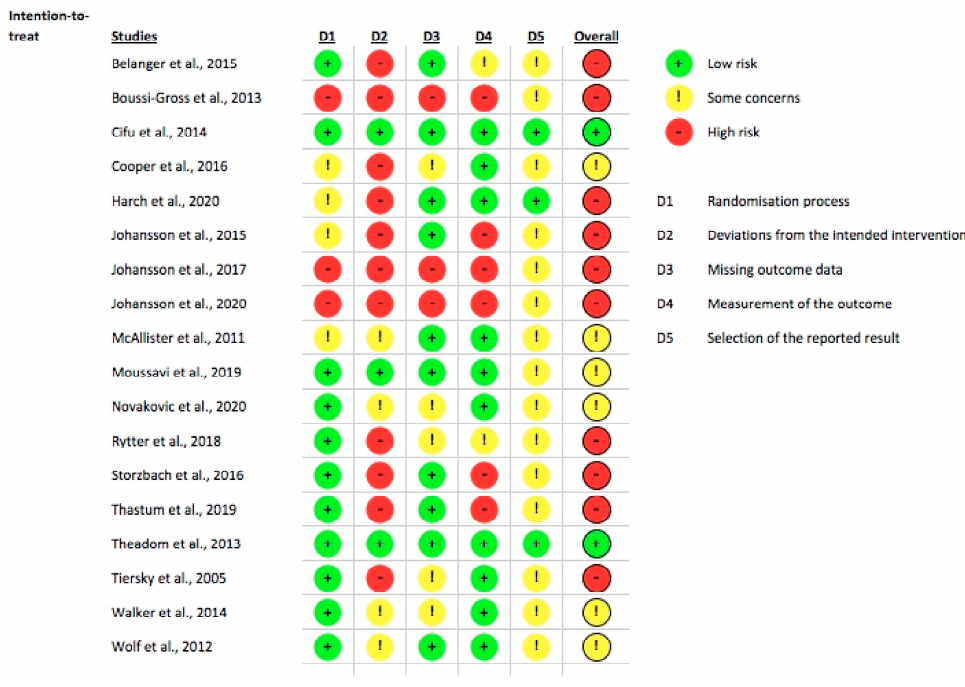
Figure A1. Risk of Bias for each study included in the Section 3.1, assessed using the Cochrane Rob2 tool revised version [19–34,36,80].